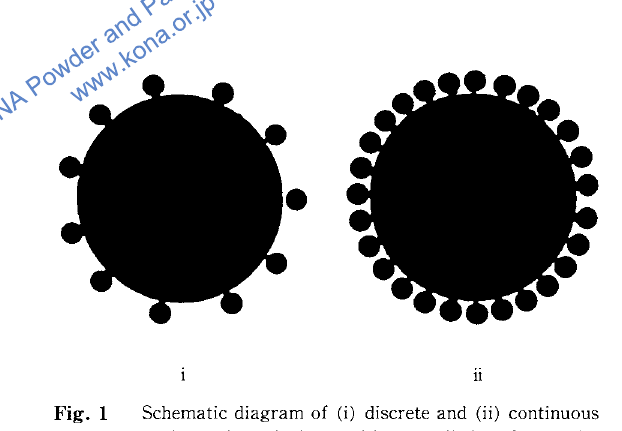
Schematic diagram of (i) discrete and (ii) continuous engineered particulates with controlled surface archi